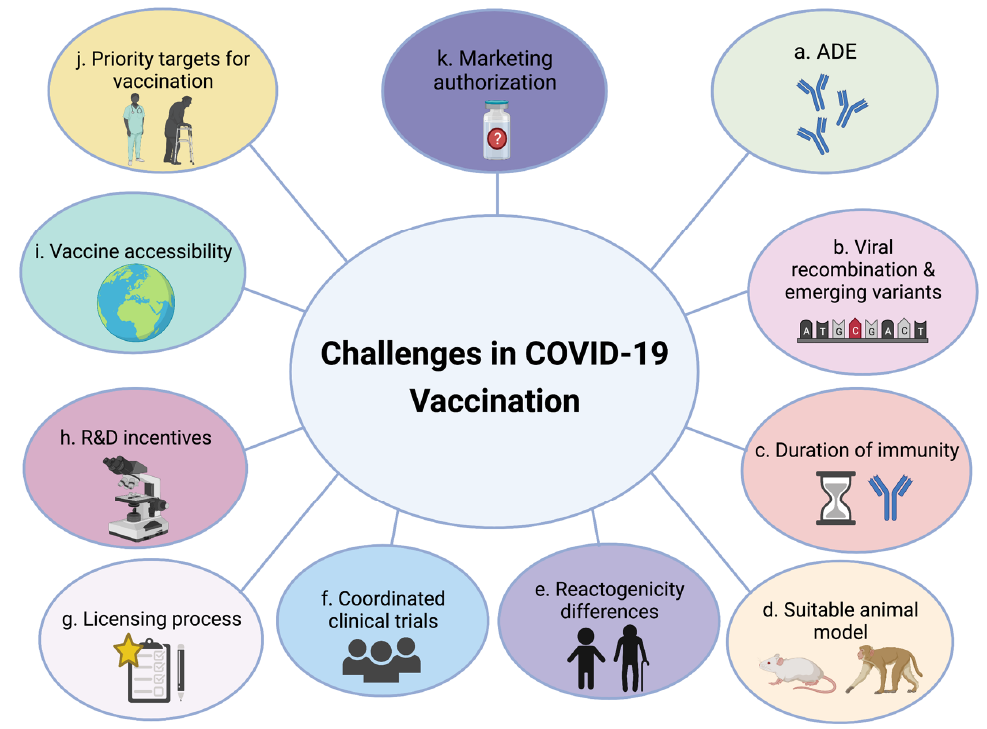
Figure 1. Challenges in COVID-19 Vaccination. ( a ) Virus-specific antibody-dependent enhancement (ADE) disease. ( b ) Impact of viral genetic recombination, high mutation rates, and emerging viral variants on vaccine effectiveness. ( c ) Duration of vaccine-acquired immunity. ( d ) Utilization/availability of suitable animal models to conduct vaccine safety and efficacy studies. ( e ) Differences in reactogenicity between age groups. ( f ) Running coordinated and valid vaccine clinical trials. ( g ) Facilitated and synchronized regulatory licensing processes. ( h ) Continuous research and development (R&D) incentives. ( i ) Public vaccine accessibility. ( j ) Deciding on priority target populations for vaccination. ( k ) Obtaining vaccine marketing authorization. The figure was created with